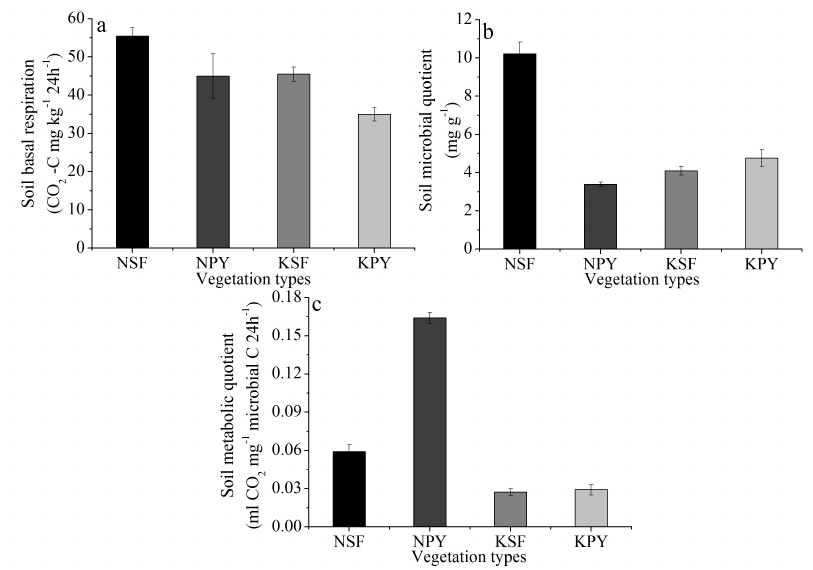
Figure 3. The soil microbial activities under different vegetation types. ( a ) Soil basal respiration; ( b ) Soil microbial quotient; and ( c ) Soil metabolic quotient.